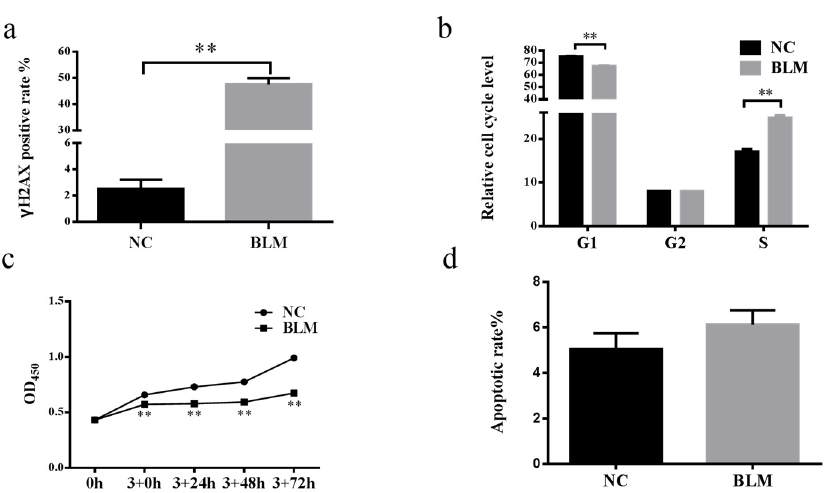
Figure 1. Effect of BLM on bovine CCs. Bovine CCs were treated with BLM (200 µ M) for 3 h. ( a ) BLM treatment enhanced the γ H2AX-positive rate. ( b ) The percentage of S phase was increased, and G1 phase was decreased significantly. ( c ) The value of OD450 was undermined after treatment with BLM for 3 h and measured for 72 h at intervals of 24 h. ( d ) BLM did not affect the cell apoptosis rate. Significant differences are represented with ** ( p <